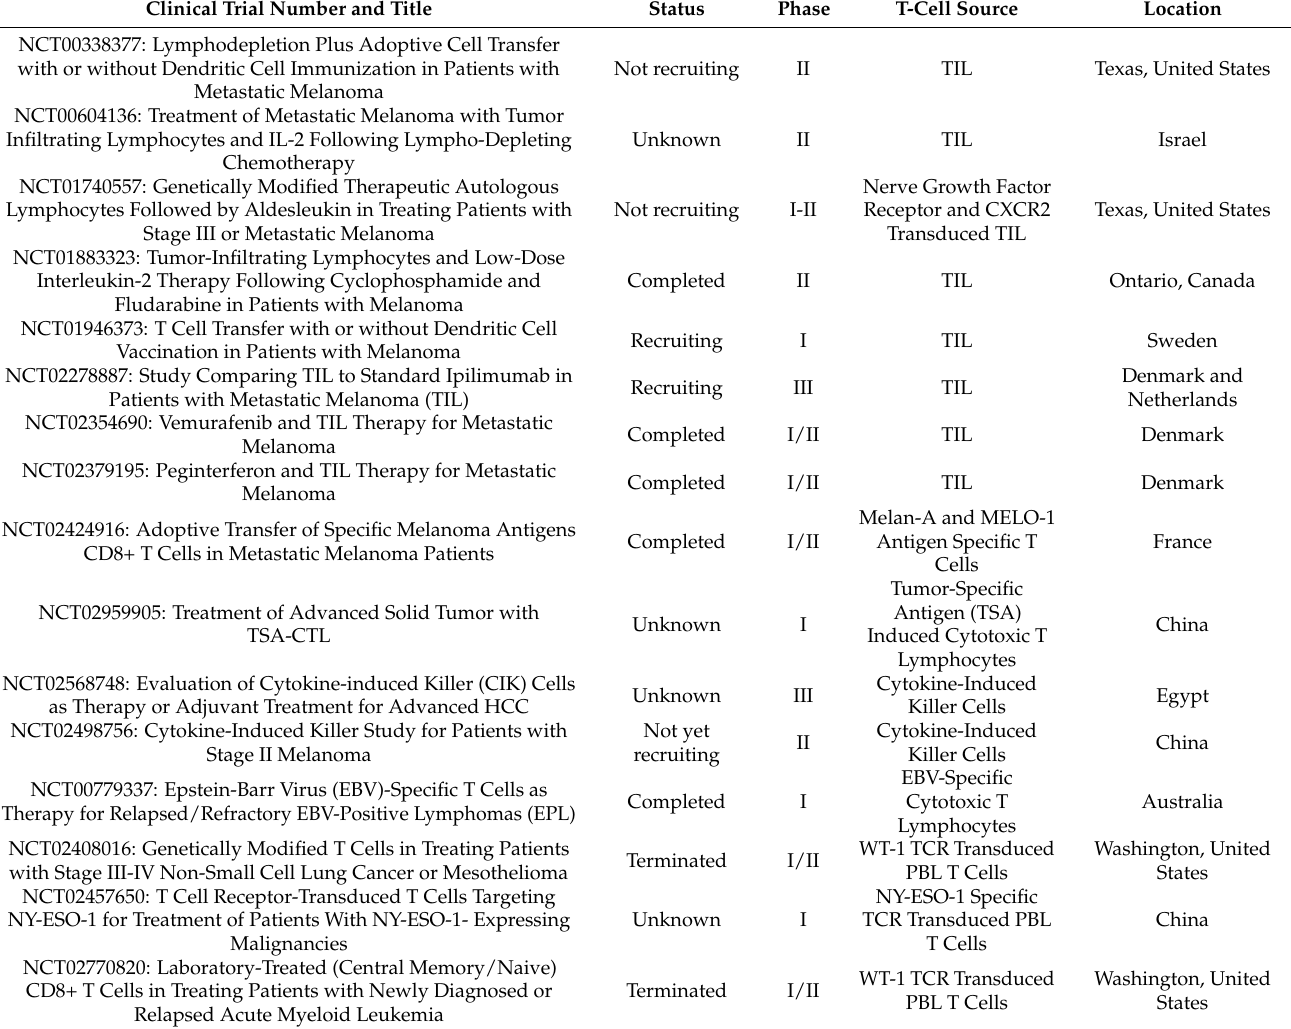
Table 1. Selected T cell immunotherapy clinical